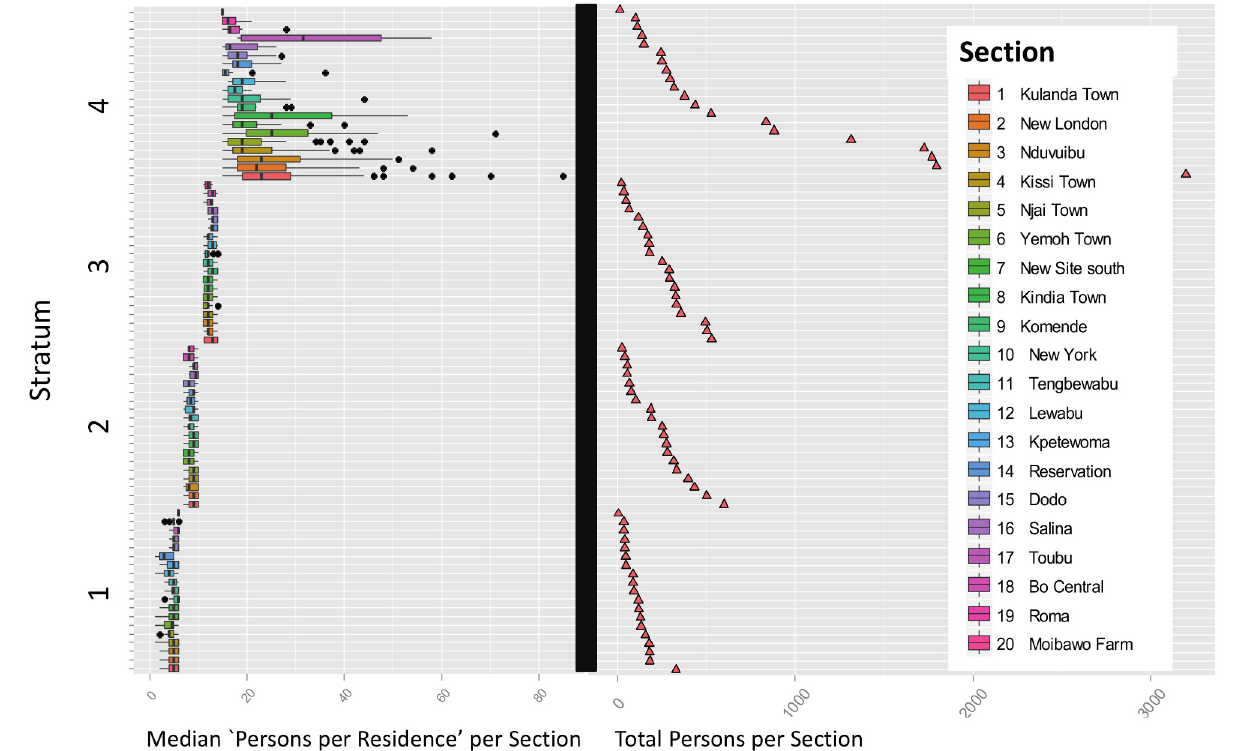
Fig 5. Quantile boxplots for optimal 4-level stratification by “ persons per residence. ” The 4-level stratification variable is “ persons per residence ” (Table 2-d). The quantile boxplots [0.25, 0.75] show the partitioning of the records by stratum for all 1,979 records. The bar in each box is the median value of persons per residence, while outliers deviating by one or more quantiles from the median are denoted as discrete points. The samples in a given stratum may be assigned from any of the 20 eligible sections. The optimized Neyman allocation has completely separated the 4 strata with respect to overlapping values of the stratification